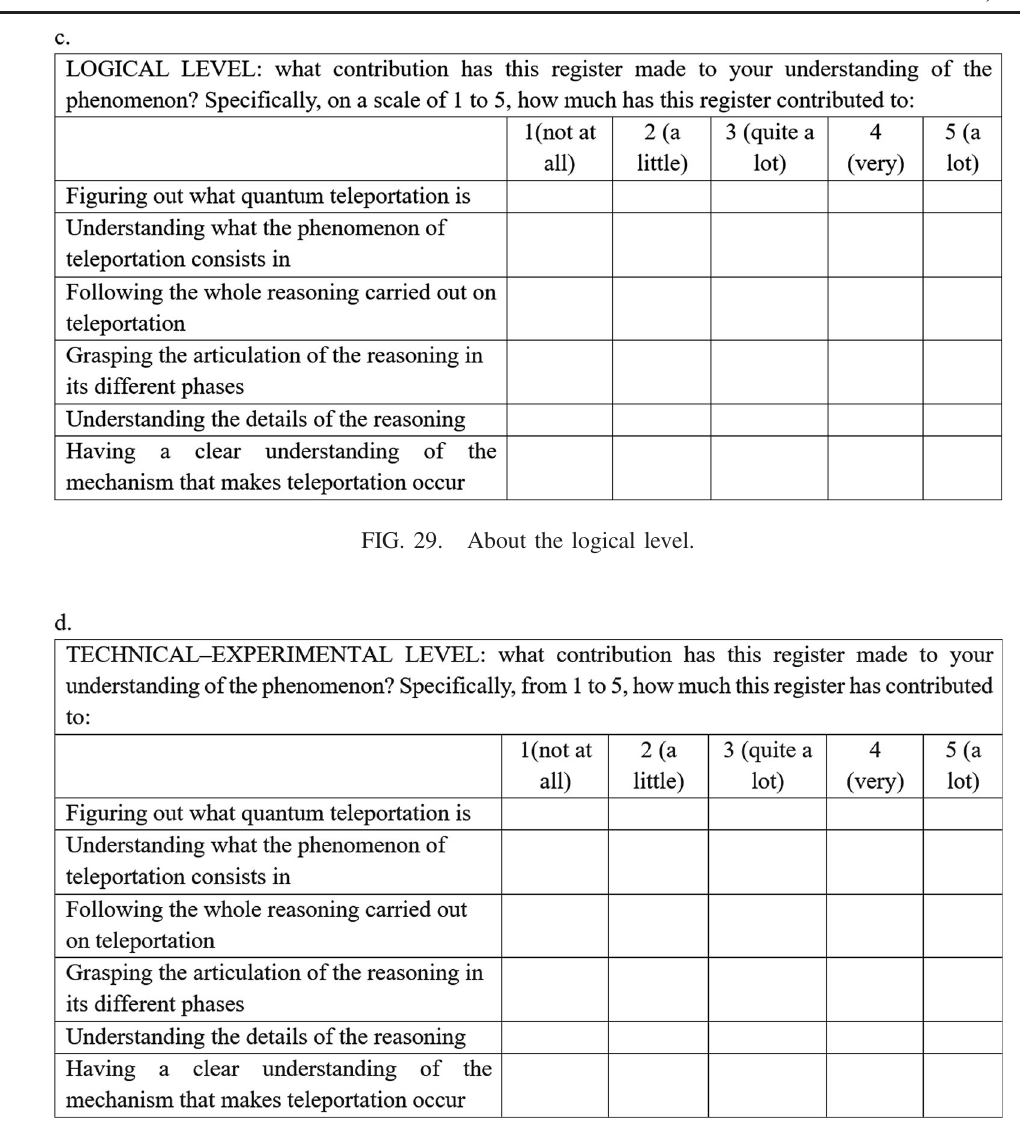
FIG. 30. About the technical-experimental level.